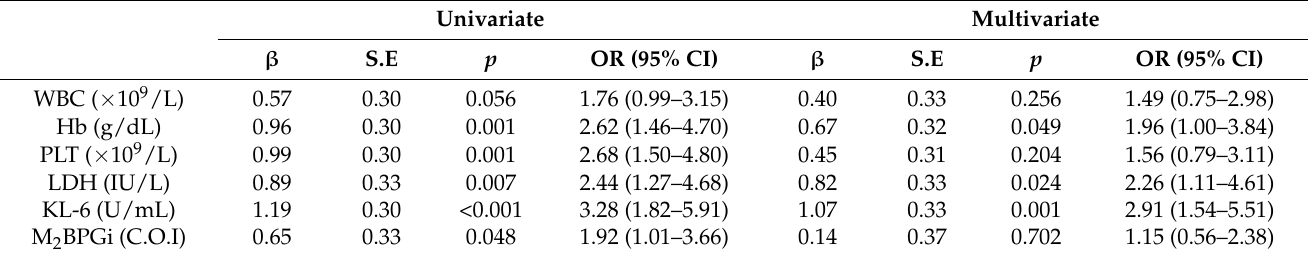
70.5%, p = 0.006) (Figure 2). Table 2. Logistic regression analyses to identify predictors of bone marrow fibrosis. Univariate Multivariate